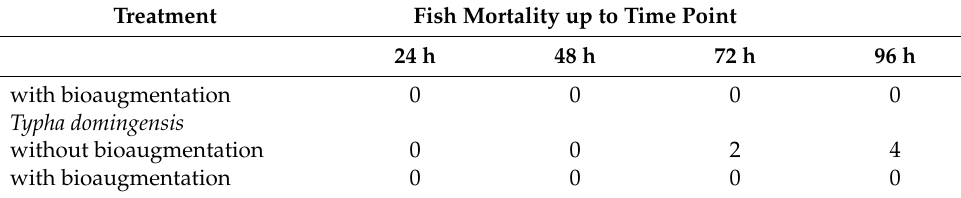
Table 5. Cont. Treatment Fish Mortality up to Time